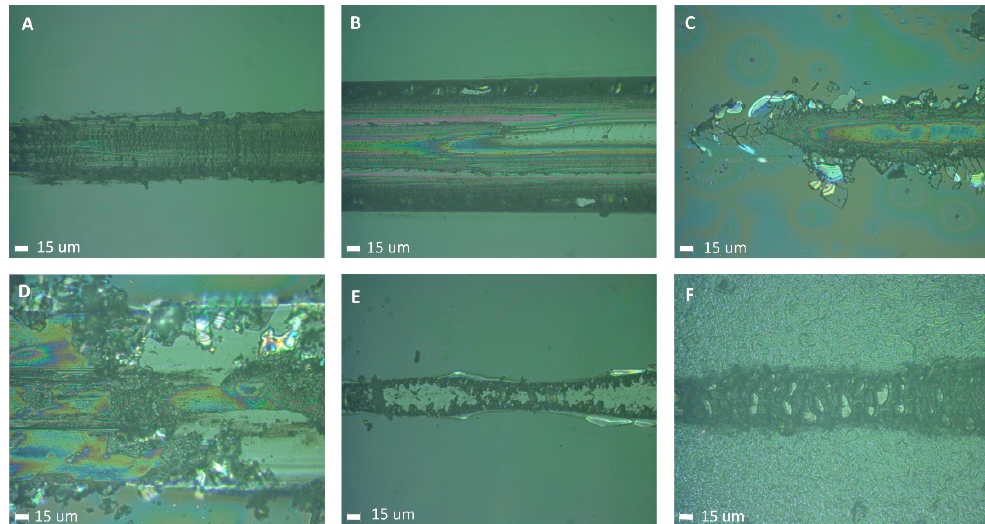
Figure 3. Microscopic representation of the critical load for individual samples: ( A )—Lc1 for sample (CF)0, ( B )—Lc3 for sample (CF)0, ( C )—Lc1 and Lc2 for sample (CF)1, ( D )—Lc3 for sample (CF)1, ( E )—Lc3 for sample (CF)6, and ( F )—Lc1 and Lc2 for sample (CF)10.